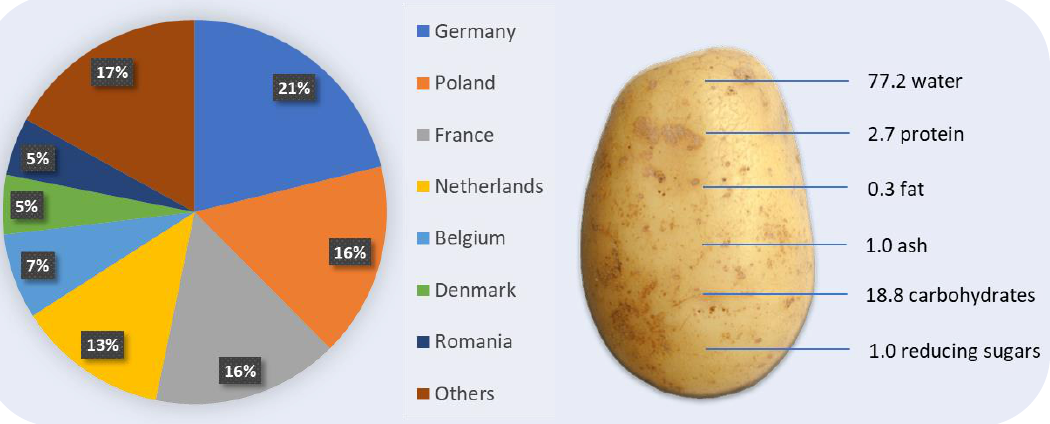
Figure 1. Production share of potatoes in the European Union in 2020 by a leading producer and chemical composition of a potato.